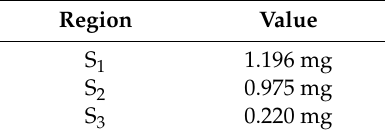
Figure 7. Mass flow curve of the connecting orifice in a single cycle. Table 3. Integral calculation results of the mass flow curve in di ff erent